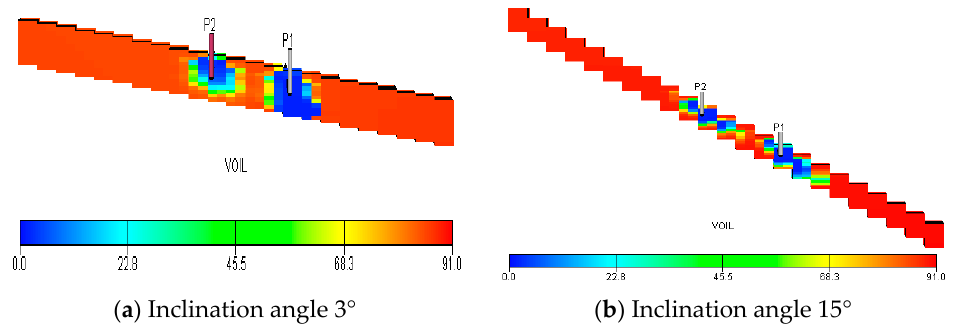
Figure 6. Viscosity distribution after well stuffy.